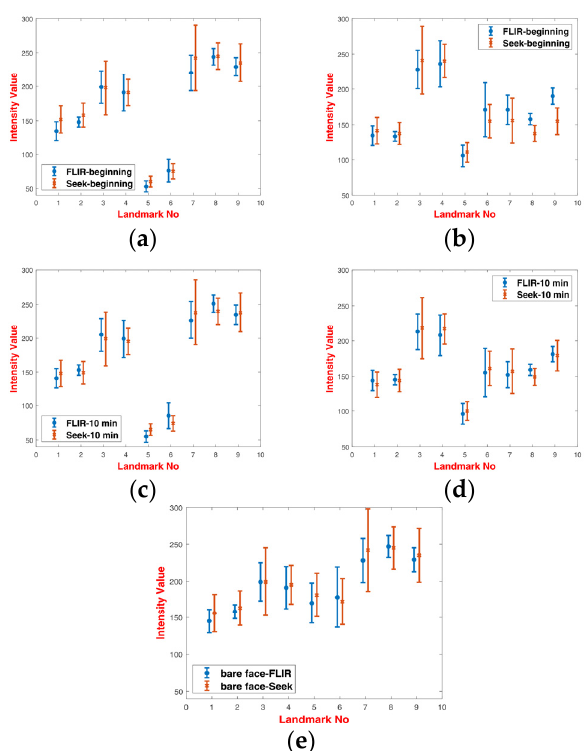
Figure 5. Graphs of the mean values of intensities with minimum and maximum values for two experiment sessions, ( a ) subjects wearing a 3D-printed mask at the beginning of the experiment, ( b ) subjects wearing a latex mask at the beginning of the experiment, ( c ) subjects wearing a 3D-printed mask after 10 min of the experiment, ( d ) subjects wearing a latex mask after 10 min of the experiment and ( e ) a bare face.